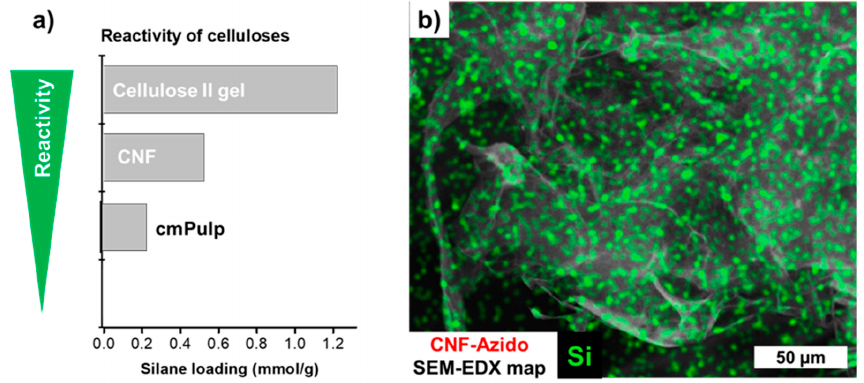
Figure 4. ( a ) Reactivity order of different cellulosic substrates towards 3-azidopropyl